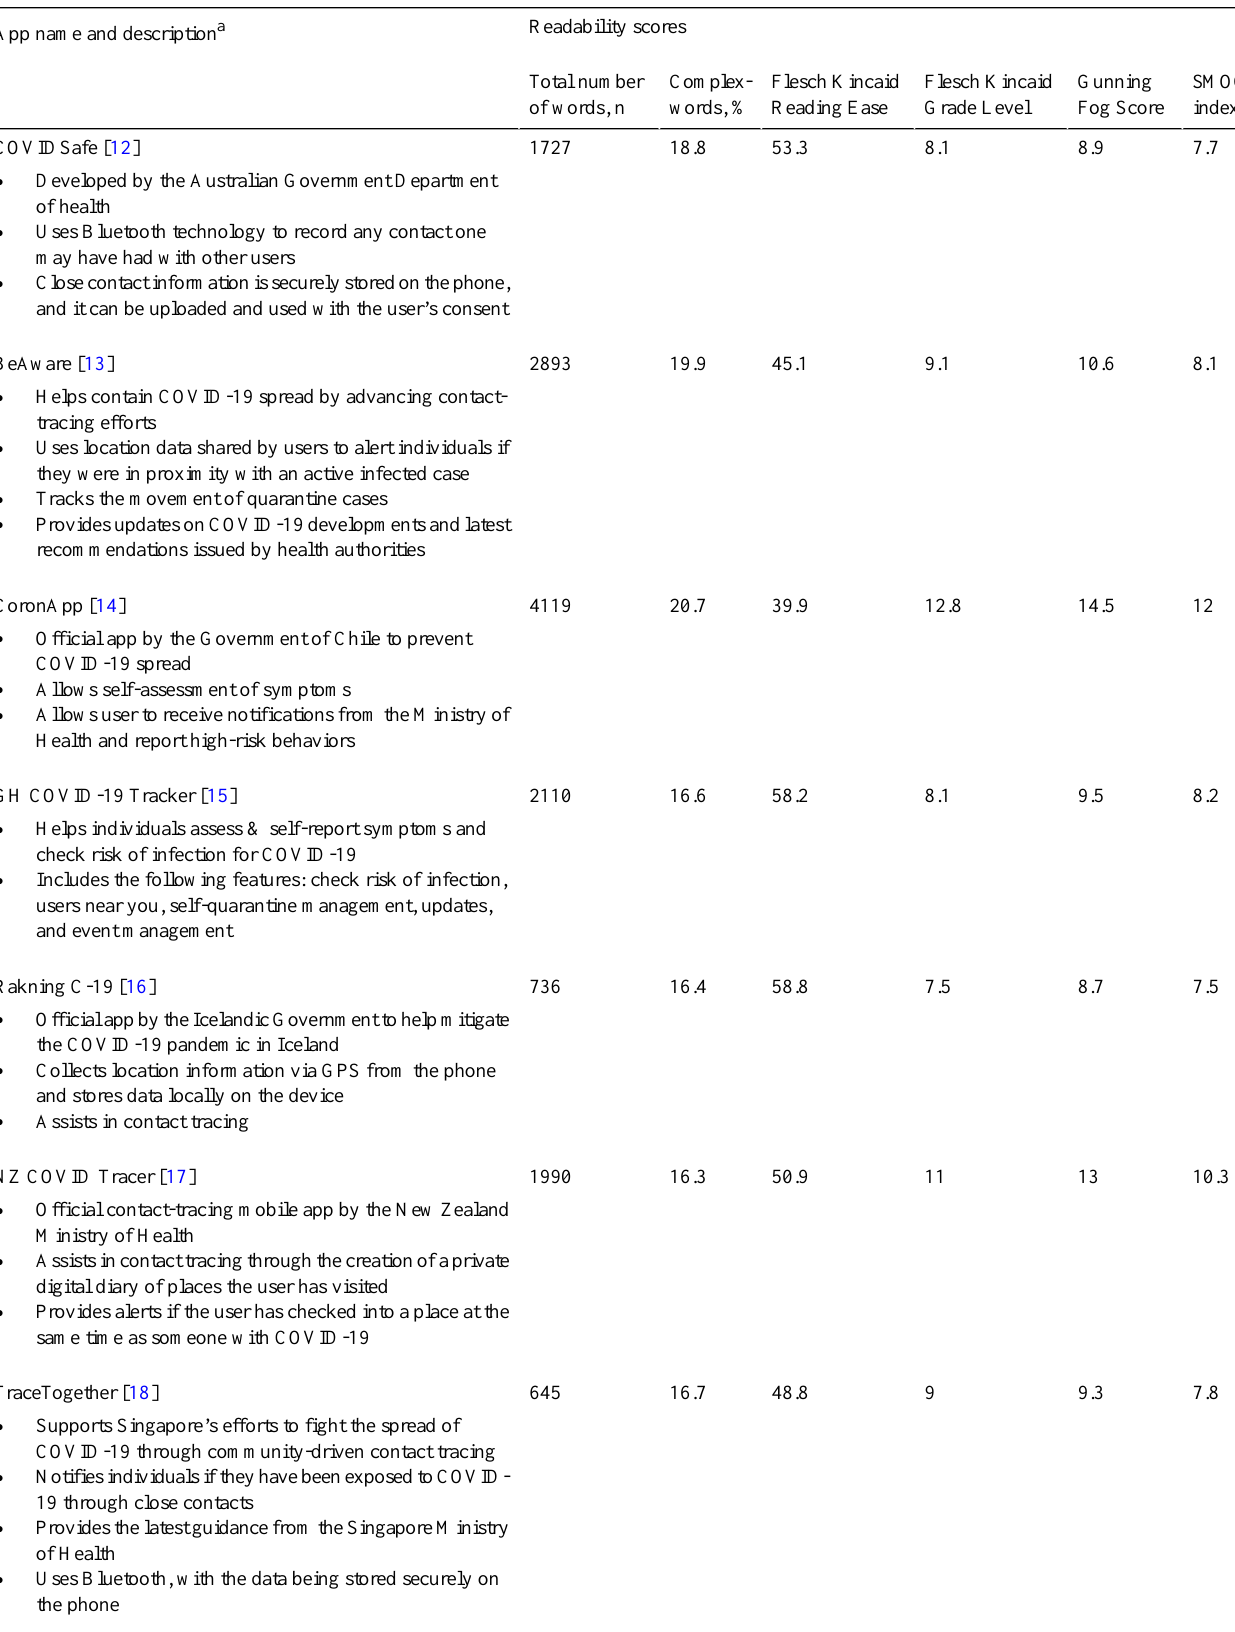
Table 1. Readability scores for the privacy policies of different COVID-19 contact-tracing apps analyzed in this study.